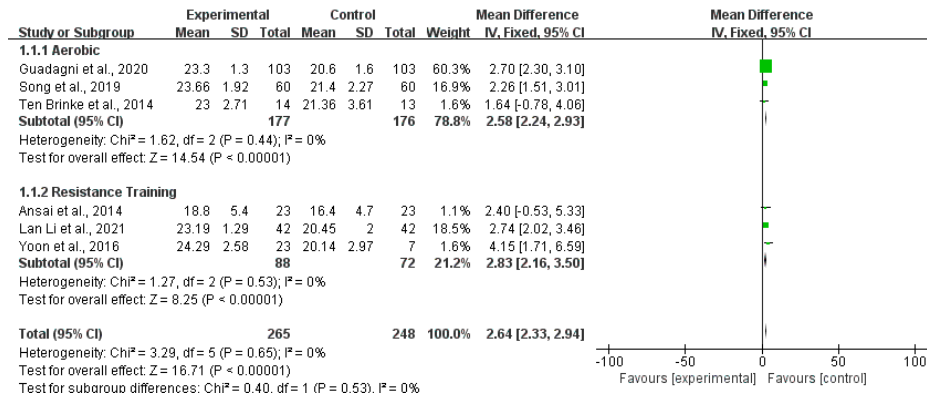
Figure 4. Forest plots of MoCA scale outcomes in overall analysis [15,19,20,22,26,30].